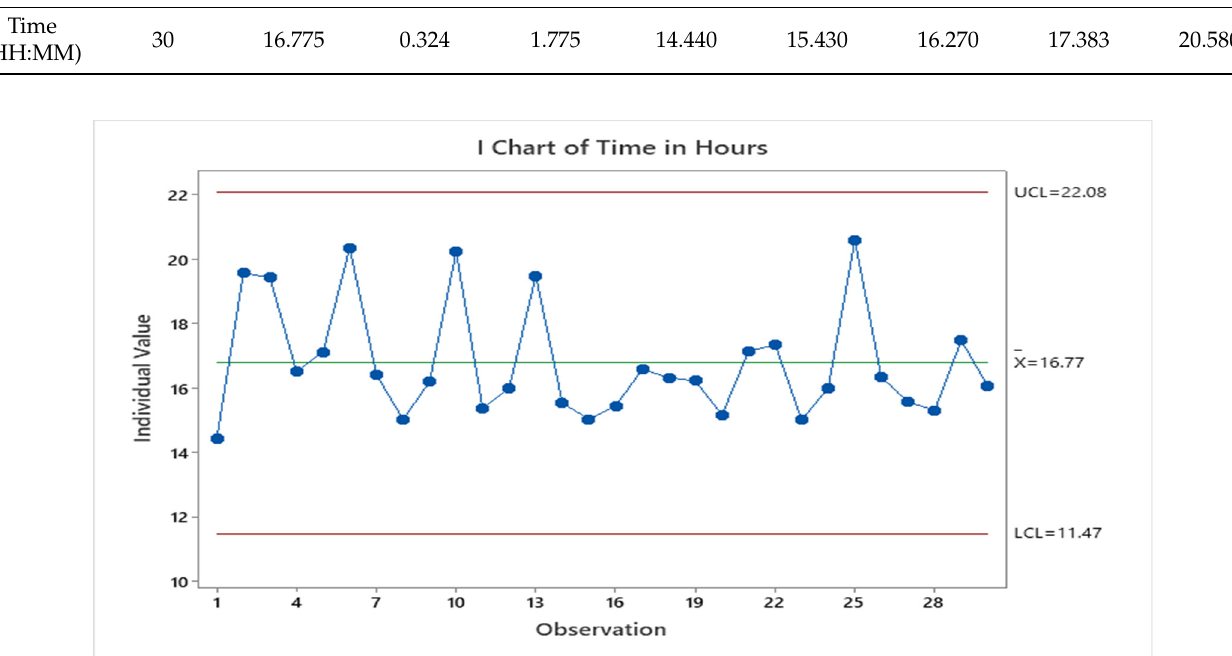
Table 7. Time taken to complete an online booking.